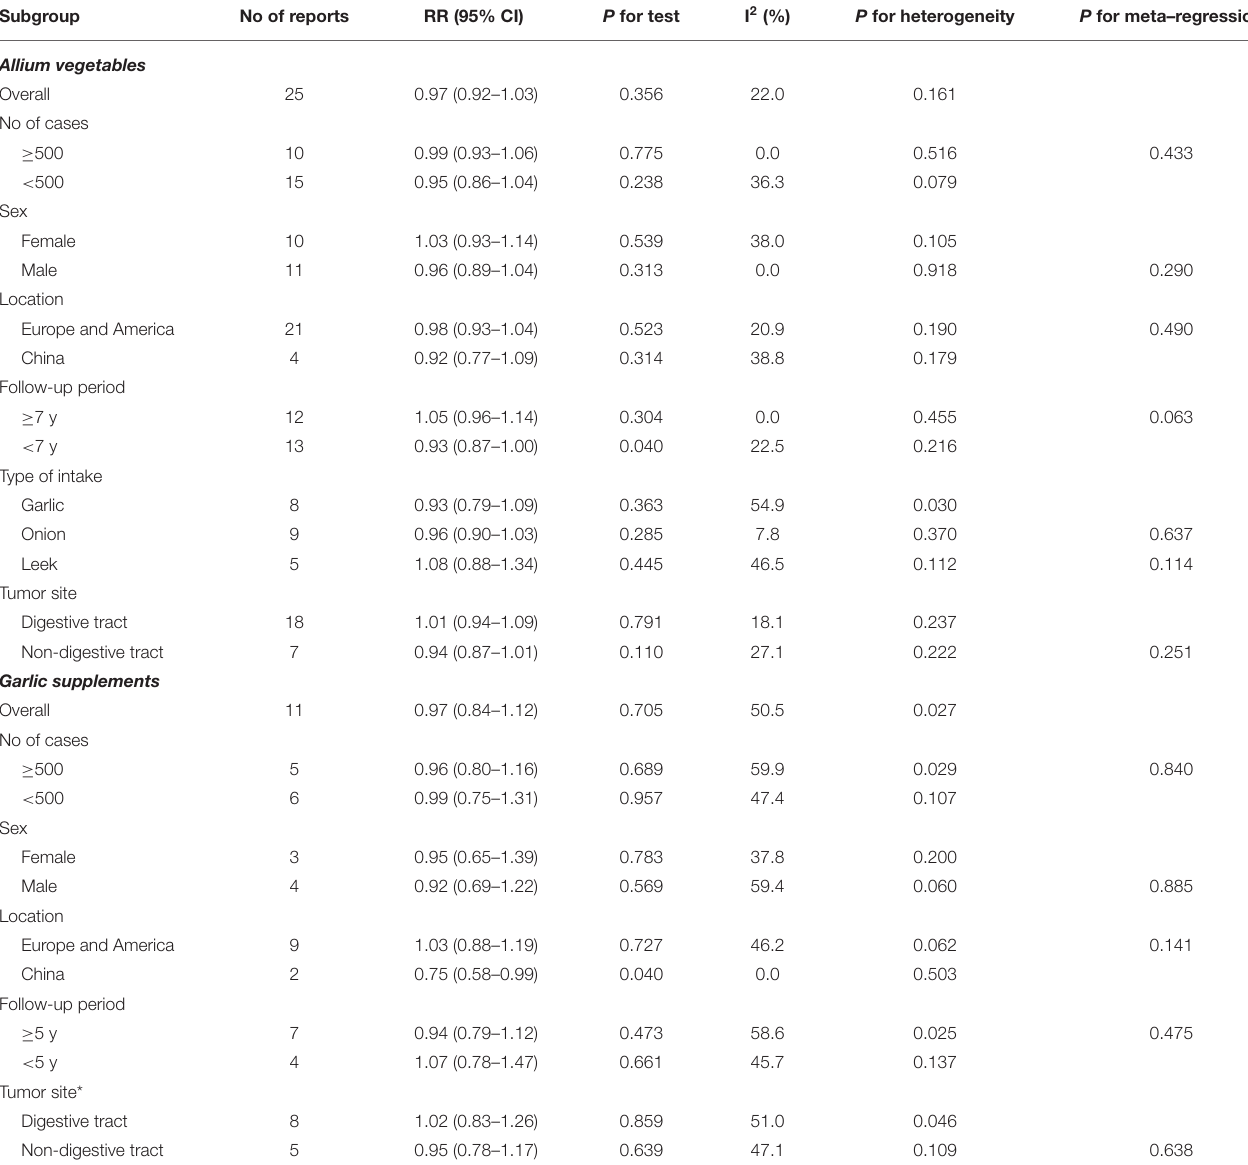
TABLE 2 | Subgroup analysis of the association between allium vegetable and supplement consumption and cancer risk. Subgroup No of reports RR (95% CI) P for test I 2 (%) P for heterogeneity P for